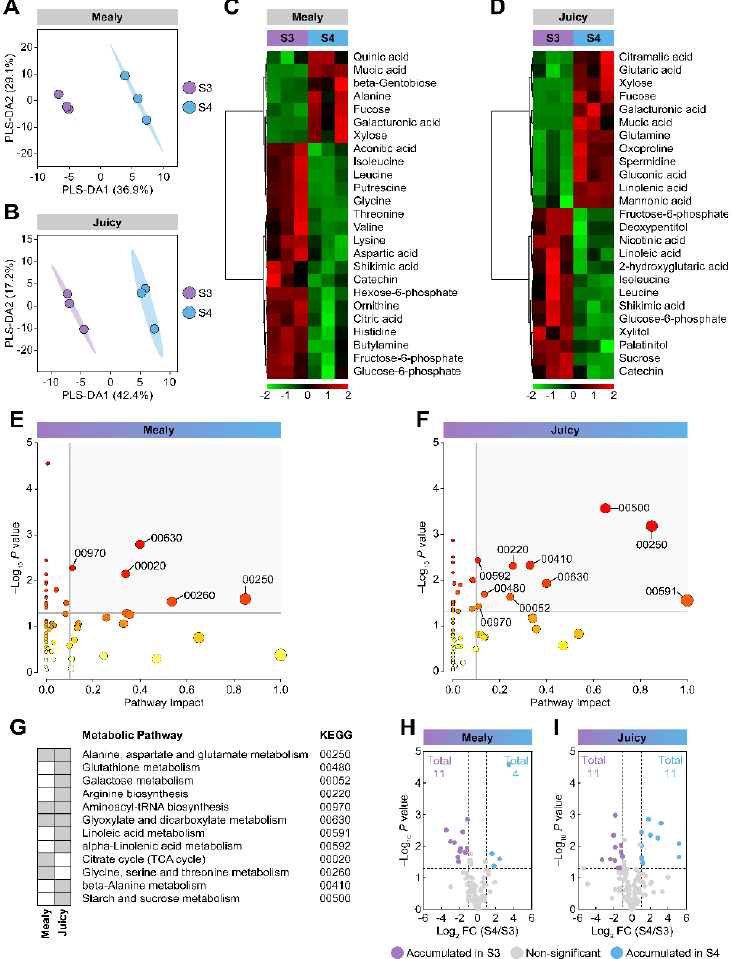
Figure 4. Multivariate analyses of metabolites of mealy and juicy ripening nectarines after cold storage. Partial Least Squares Regression Discriminant Analysis (PLS − DA) for S3 and S4 stages and score plot of mealy ( A ) and juicy ( B ) varieties. The identified metabolites were employed as predictor variables and the varieties as response variables. Heatmap representation based on top 25 metabolites identified by PLS − DA VIP of S3 and S4 stages from the mealy ( C ) and the juicy ( D ) varieties. The columns represent biological replicates for each treatment. The similarity measure used to group the different characteristics was based on Euclidean distance and Ward’s linkage from three biological replicates ( n = 3). Pathway analysis of S3 and S4 stages from the mealy ( E ) and the juicy ( F ) varieties. Perturbed metabolic pathways and their KEGG entries are highlighted in grey ( G ). Three biological replicates ( n = 3) and the Arabidopsis thaliana pathway library were used for this analysis. Volcano plots showing differentially accumulated metabolites (DAMs) from mealy ( H ) and juicy ( I ) varieties.